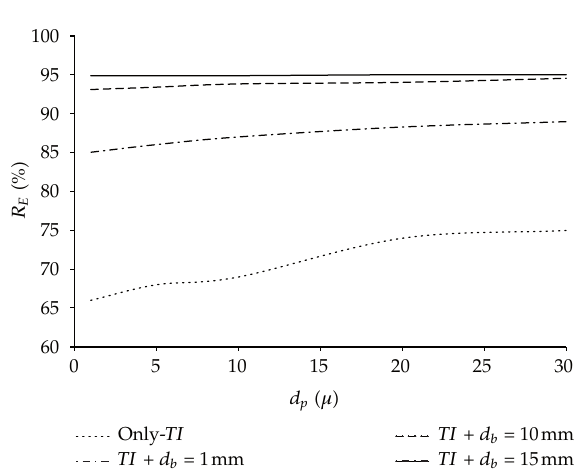
Figure 9: Non metallic Inclusion removal rate considering only the fluidynamics e ff